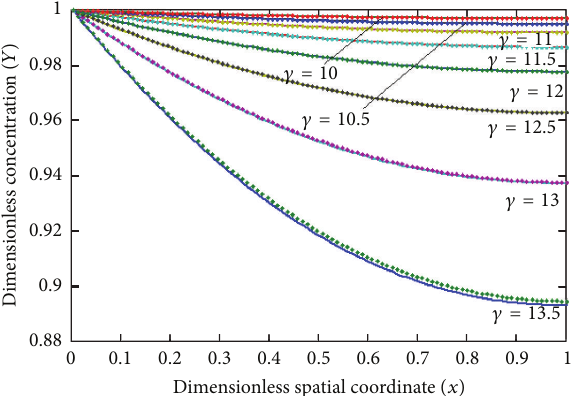
Figure 3: Dimensionless concentration Y versus dimensionless spatial coordinate x using (5) for Le = 0.233, 𝛽 = 4.287, 𝜙 2 = 1000, and various values of 𝛾 . Solid lines represent the analytical solution, whereas the dotted lines are for the numerical solution.